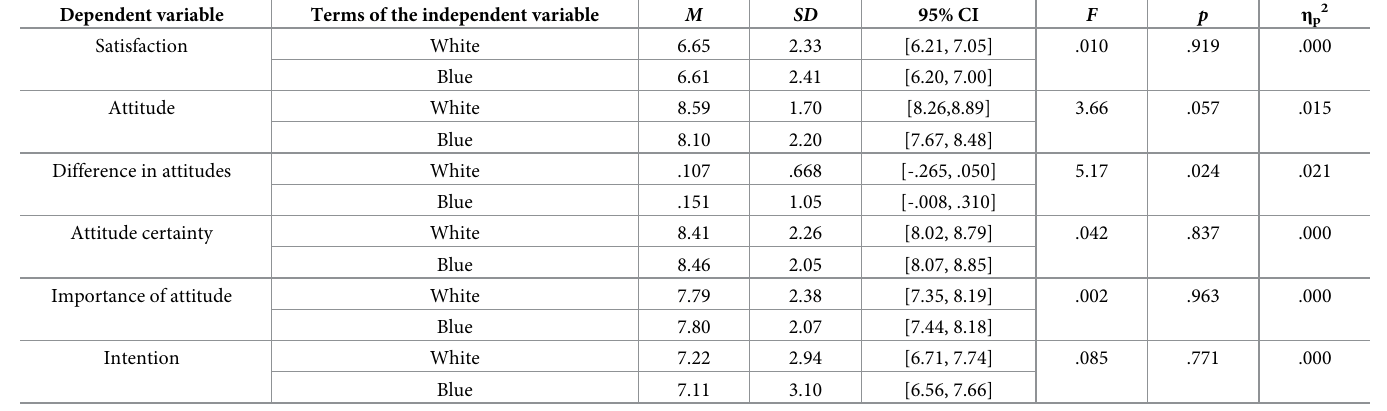
Table 4. Effects of color and contrast background characteristics (summary of ANOVA results). Dependent